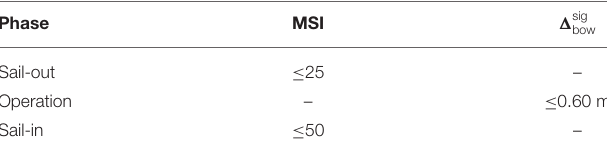
TABLE 2 | Thresholds used to define the feasibility of the task for the three different phases. Phase MSI 1 sig bow Sail-out ≤ 25 – Operation – ≤ 0.60 m Sail-in ≤